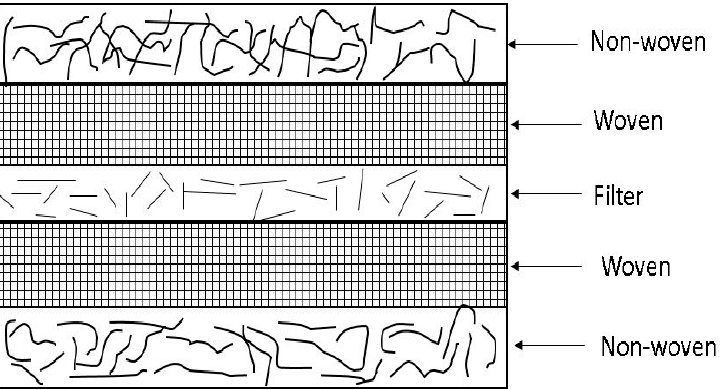
Figure 2. The hand lay-up of different layers of mats from bottom to top used in the polyurethane composite.